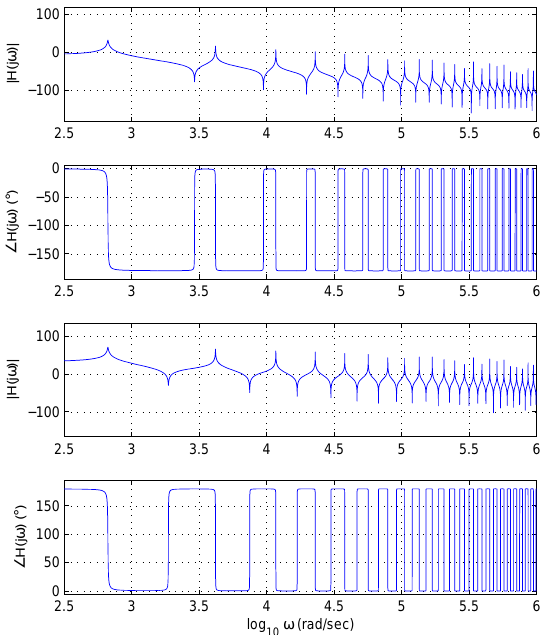
Figure 6. Bode plot of the response of the whisker shaft subjected to a point force applied to the end of the beam. Both the outputs have resonances located at the same frequencies due to the same denominators in the transfer functions. At resonance frequencies, the phase decreases by 180 ◦ and is in phase, while at anti-resonance frequencies, the response is 180 ◦ out of